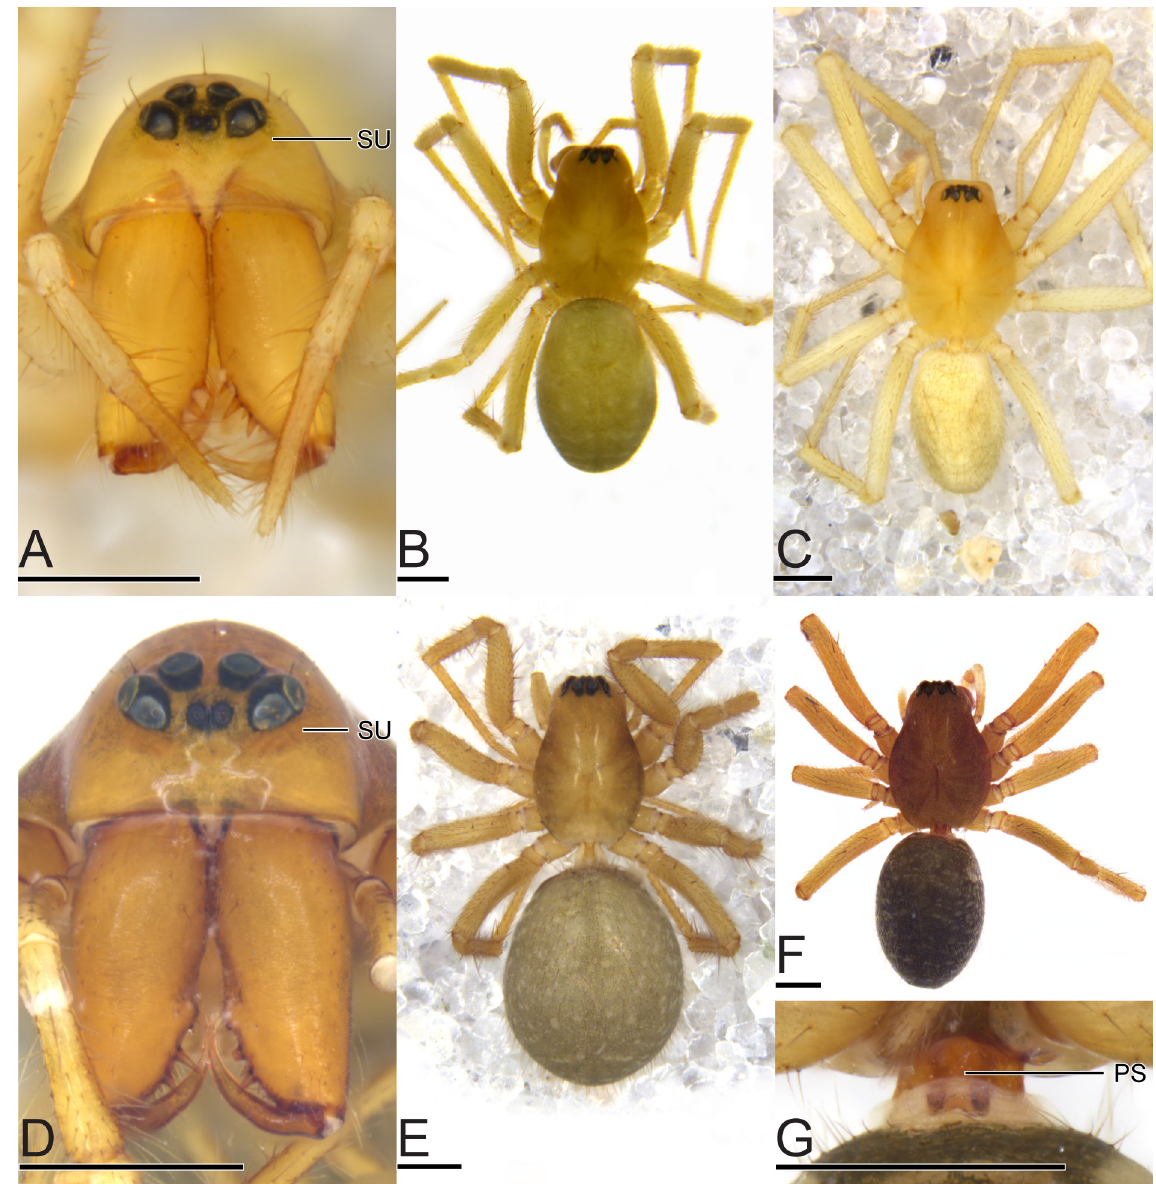
Fig. 6. Afroneta flavescens sp. nov. A–B . Allotype, ♀ (UPSZMC 67564). A . Habitus, frontal. B . Dorsal. C . Holotype, ♂ (UPSZMC 67563), habitus, dorsal. — D–G . Afroneta elgonensis Merrett, 2004. D . Allotype, ♂ (UPSZMC 67572), habitus, frontal. E . ♀, habitus, dorsal. F-G . Allotype, ♂ (UPSZMC 67572). F . Habitus, dorsal. G . Petiolus, ventral. Scale bars: 500